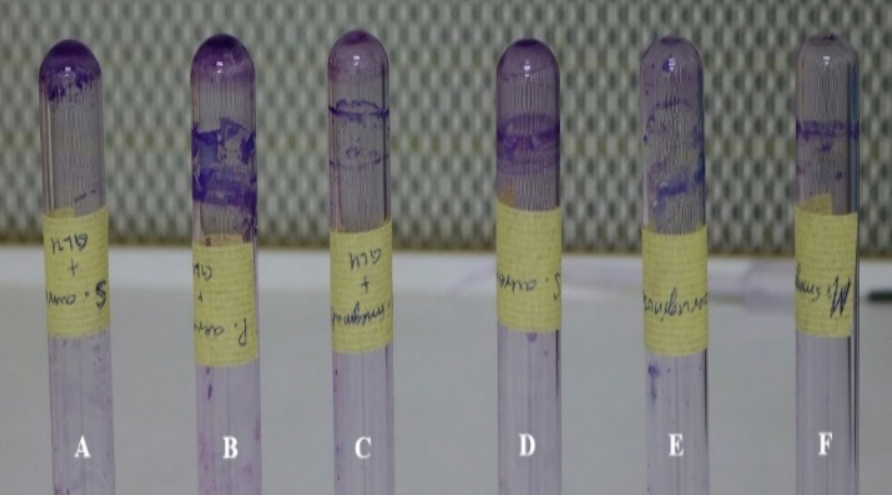
Figure 5. Biofilm formation by ( A ) S. aureus + glucose; ( B ) P. aeruginosa + glucose; ( C ) M. smegmatis + glucose; ( D ) S. aureus ; ( E ) P. aeruginosa; ( F ) M. smegmatis .